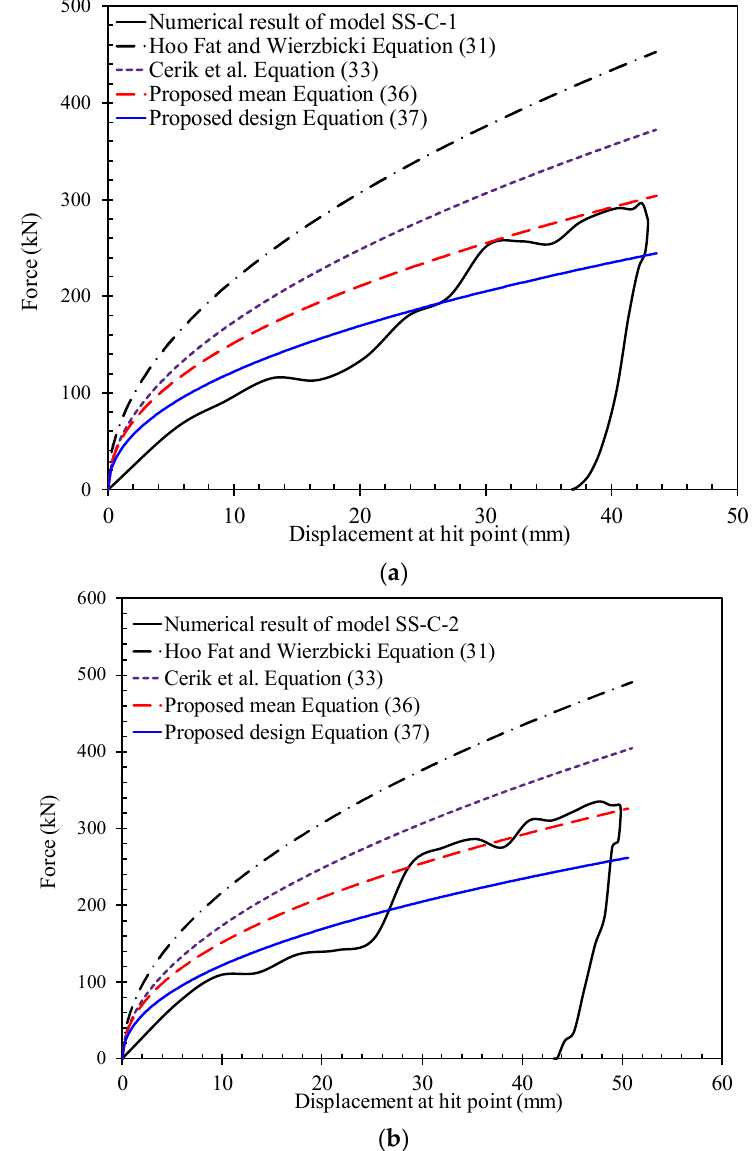
Figure 29. Comparison of predicted force-displacement relations using proposed formulations with other existing formulations for stringer-stiffener cylinders: ( a ) Model SS-C-1; ( b ) Model SS-C-2.